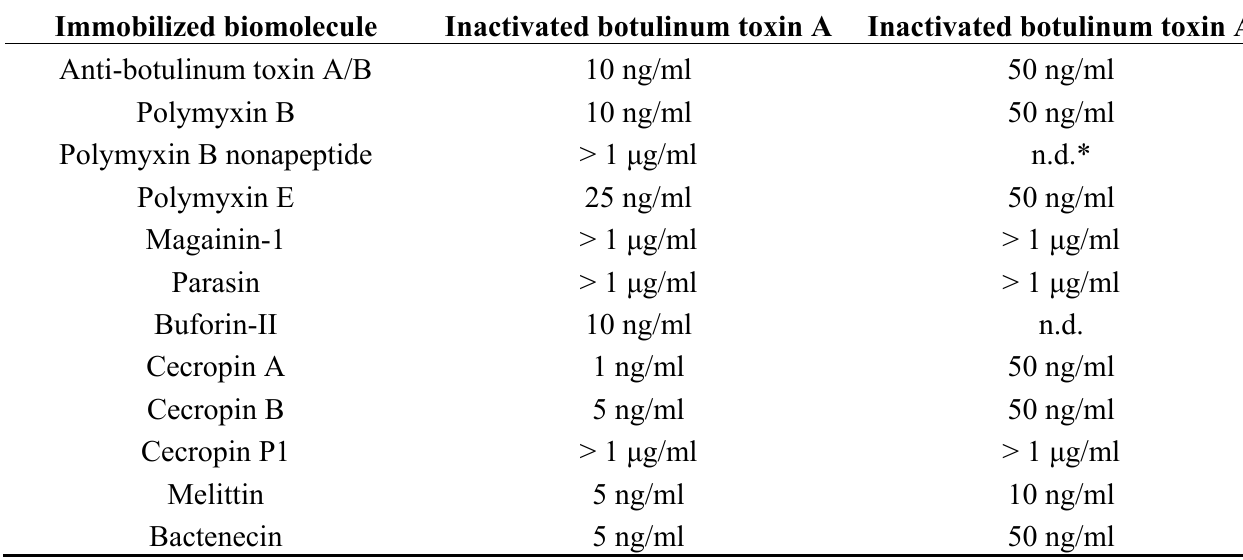
Table 2. Detection limits for inactivated toxins in "sandwich"